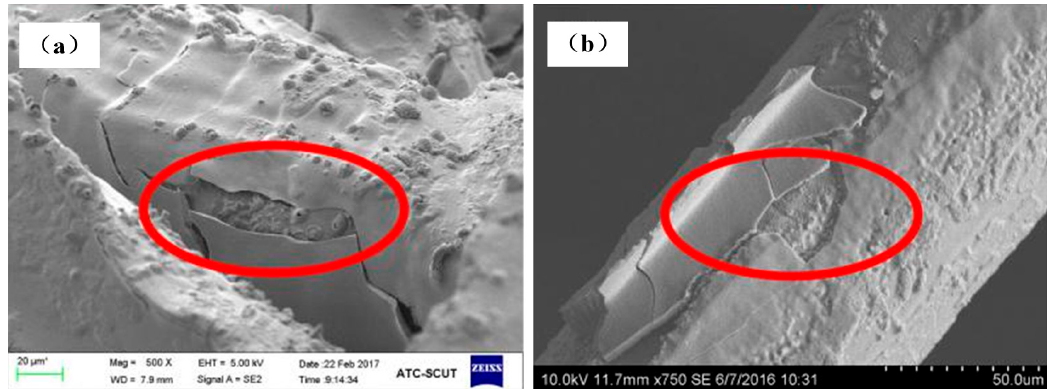
Figure 8. SEM of samples for 60 min ultrasonic adhesion test: ( a ) made of cutting fibers; ( b ) made of commercial drawing fibers.